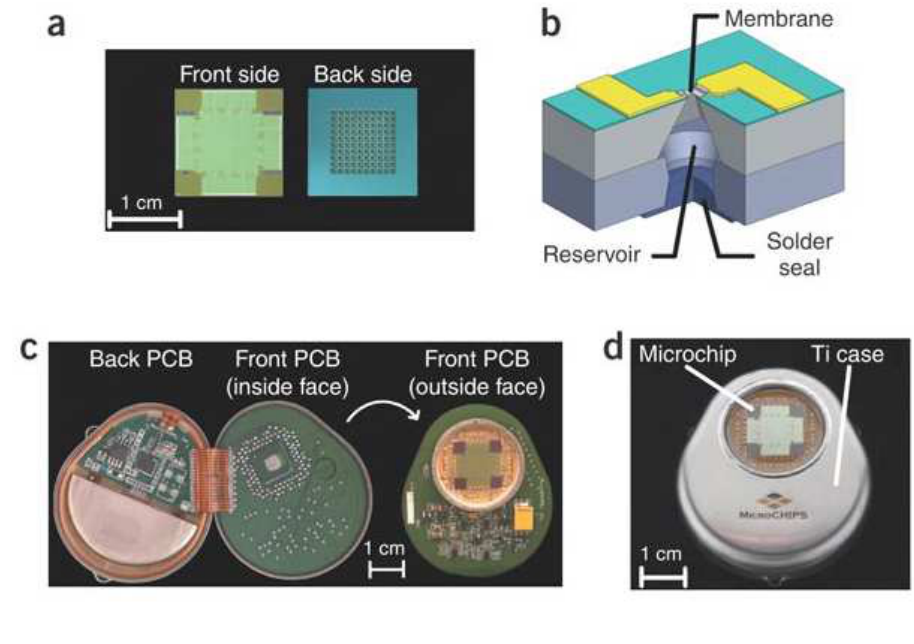
Figure 5. (a) Front and back of the 100-reservoir microchip. (b) Representation of a single reservoir. (c) Electronic components on the printed circuit board (PCB) in the device package. (d) The assembled implantable device. Ref